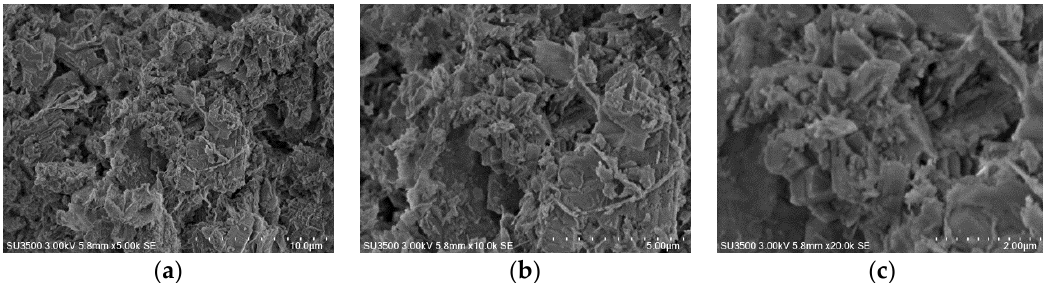
Figure 2. The SEM images of the natural zeolite collected from the surface with the various magnification of ( a ) 5000×, ( b ) 10,000×, and ( c ) 20,000×, respectively.